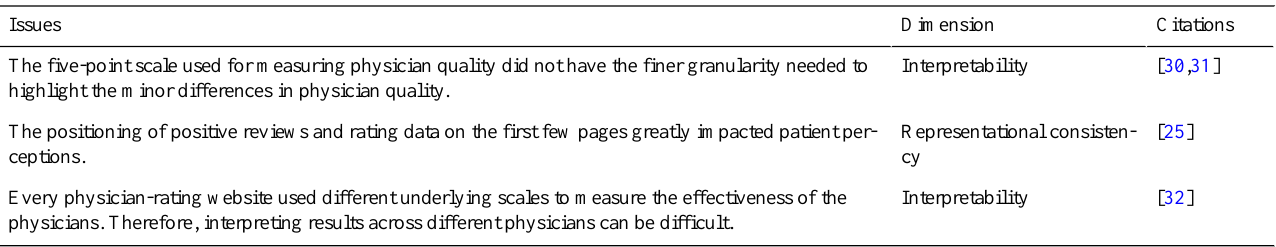
Table 3. Representational data quality issues.